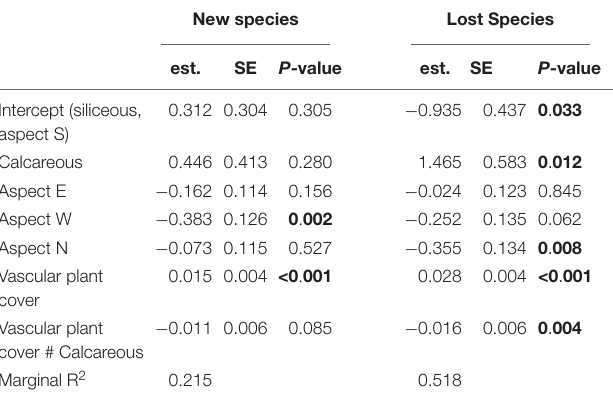
TABLE 5 | Effects of bedrock, aspects, vascular plant cover, and the interaction between vascular plant cover and bedrock on the number of new/lost species. New species